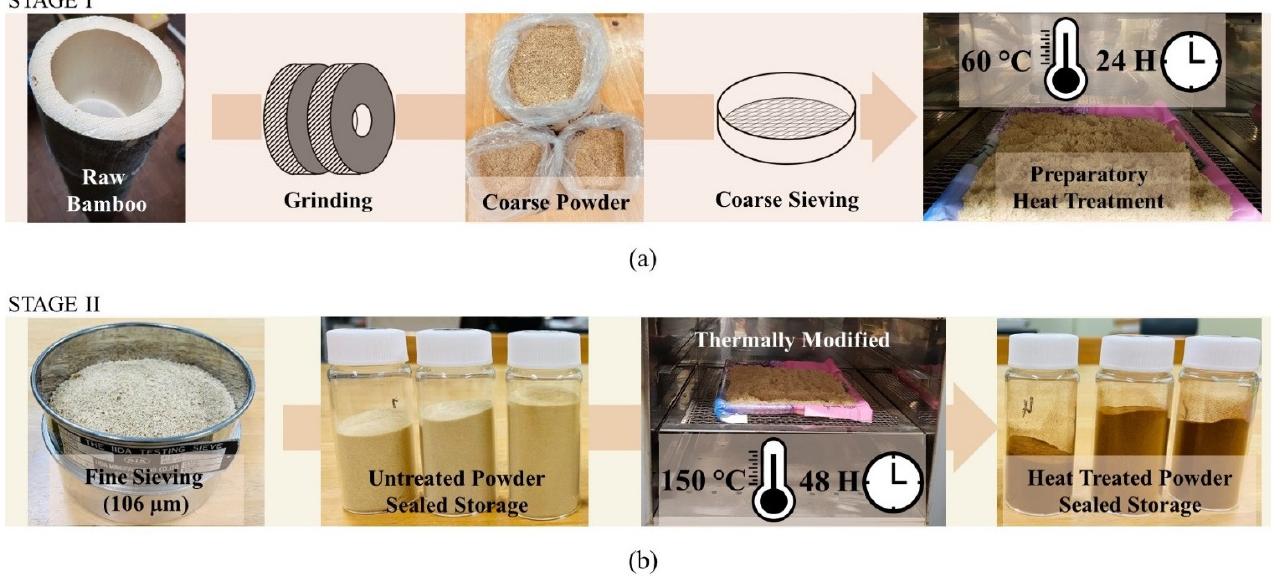
Figure 1. Schematic illustration of methodology of specimen preparation in this study. ( a ) Stage I of the treatment involving grinding, coarse sieving and preparatory heat treatment, and ( b ) Stage II of the treatment involving fine sieving, thermal treatment and sealed storage.